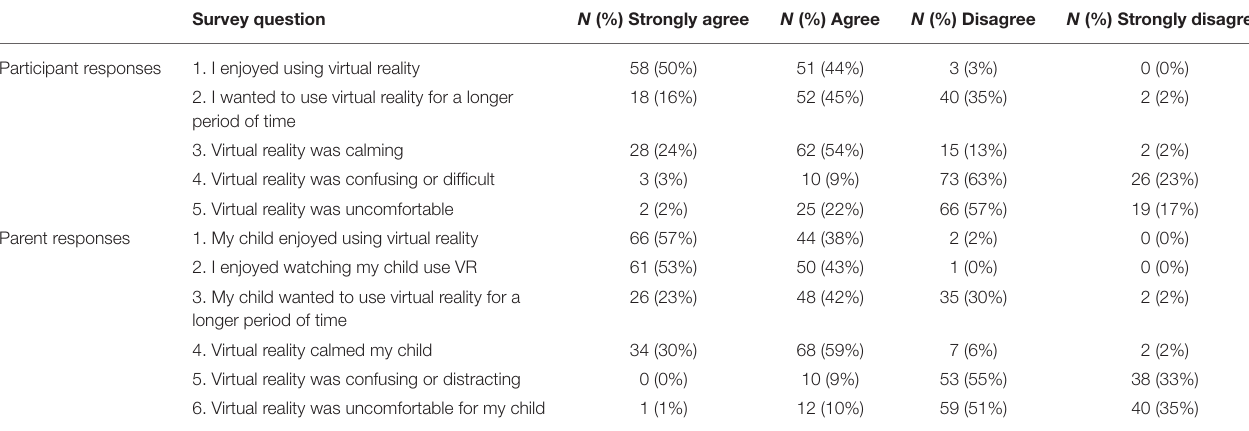
TABLE 2 | Participant and parent survey responses ( N =